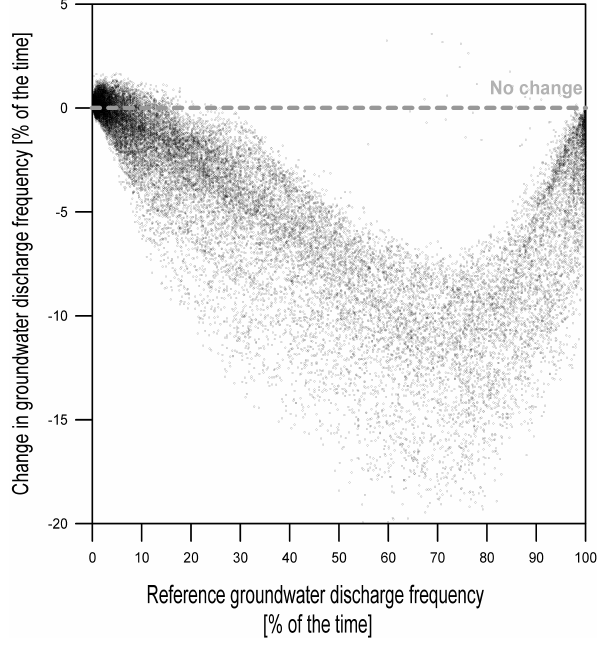
Fig. 12. Scatter-plot of reference groundwater discharge frequency (x-axis) versus the change in groundwater discharge frequency from the reference period (1960–1991) to the average future period 2070–2101 (y-axis). The groundwater discharge frequency is the percentage of time that a certain model cell has a positive ground- water discharge flux, the quantity of this flux is not taken into ac- count. Every point in the graph represents a model cell in the wa- tershed where at least during one time step of the reference period groundwater discharge